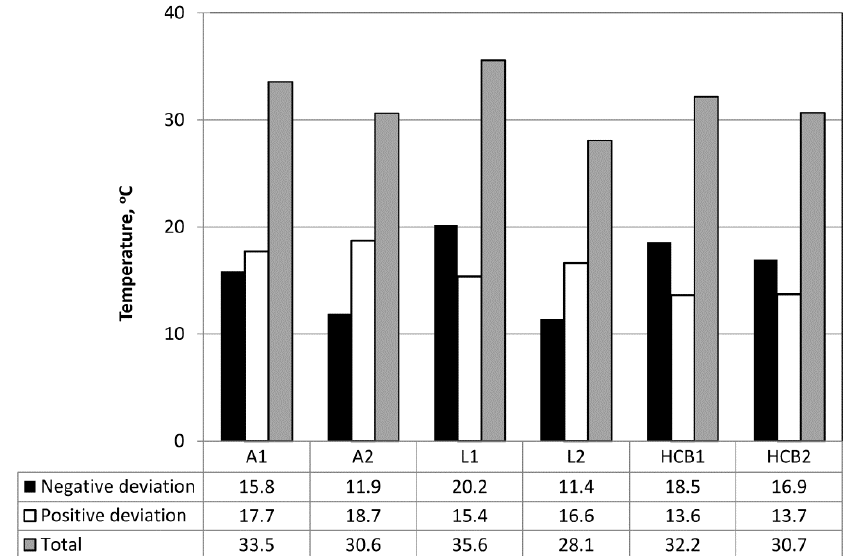
Figure 8. Annual average deviation of indoor temperature from comfort temperature for six different wall